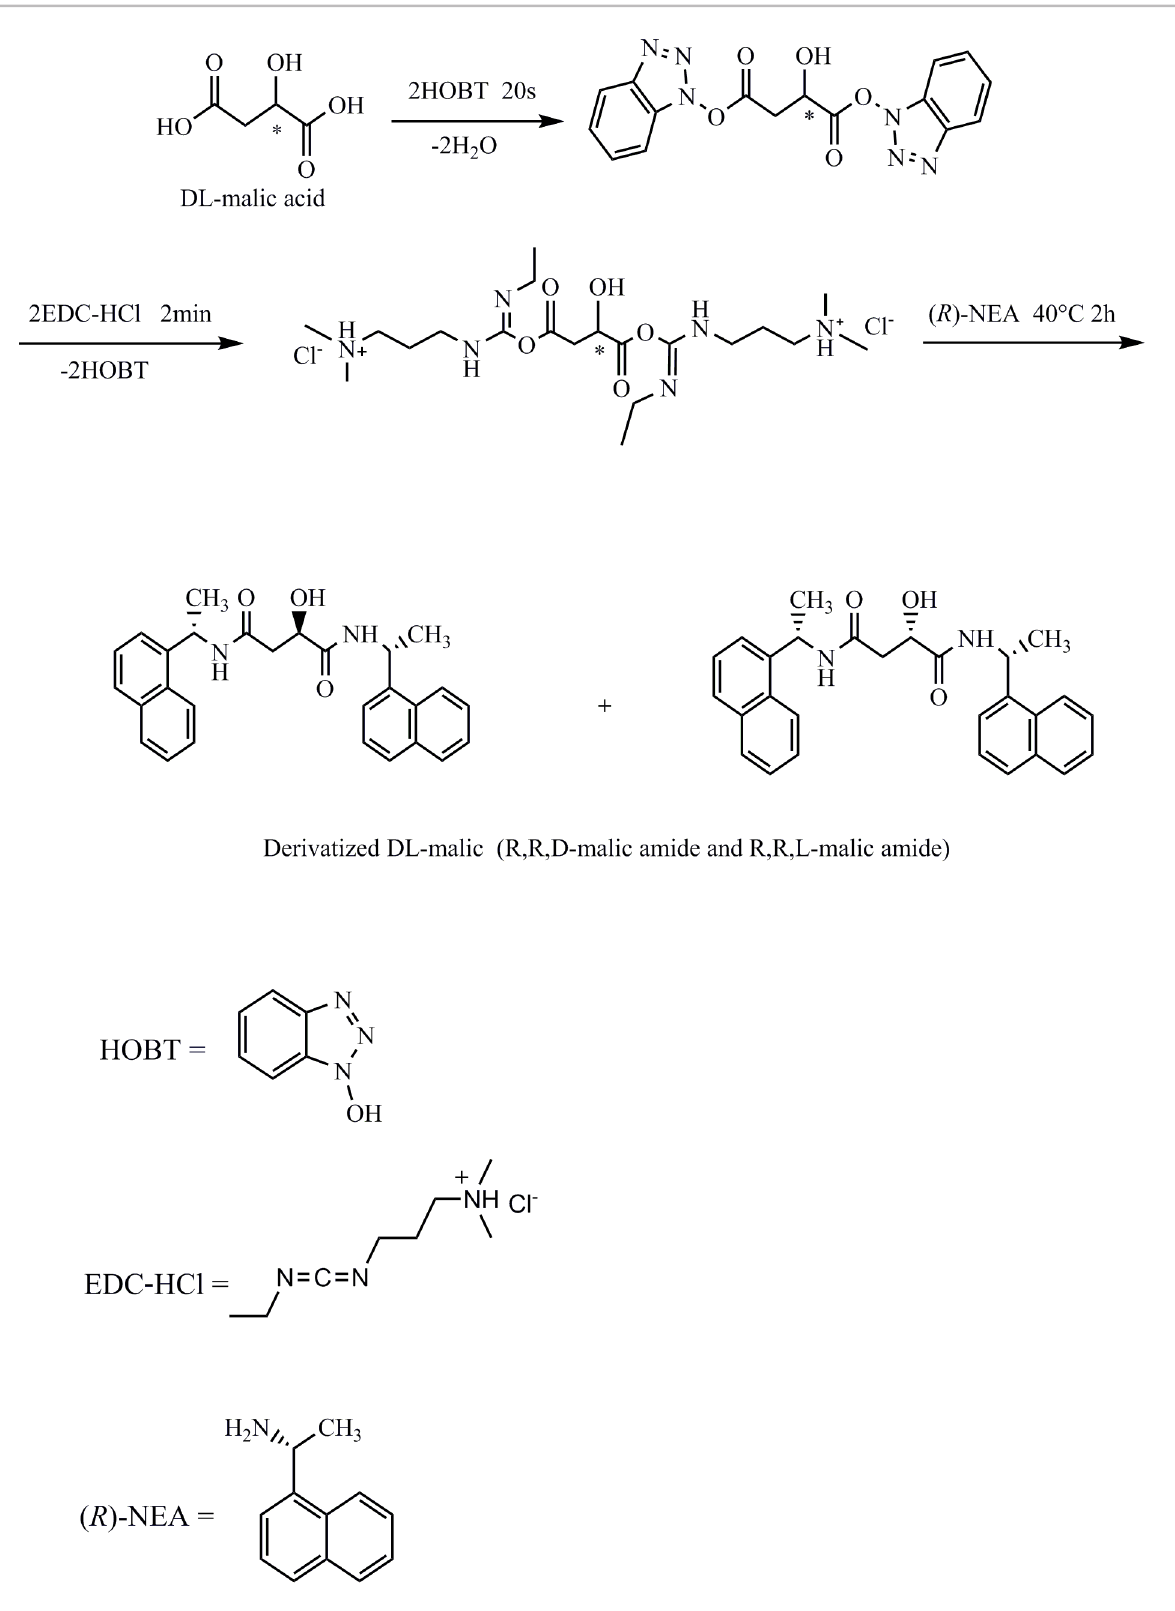
FIGURE 1 - The reaction scheme of ( R )-NEA with the carboxyl group of DL-malic acid molecule, HOBT is an activator, and EDC-HCl is a coupling